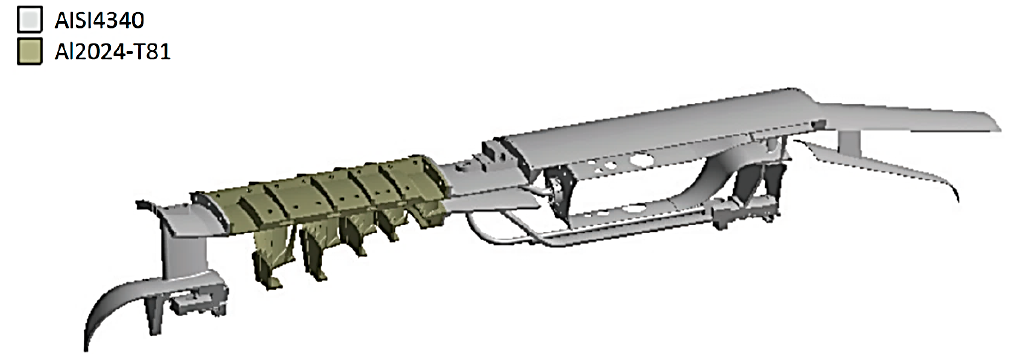
Figure 4. A one-eighth section of the static assembly showing the chosen metallic alloys for each component. Table 1. Compositions of the metallic alloys in terms of elements percentage.